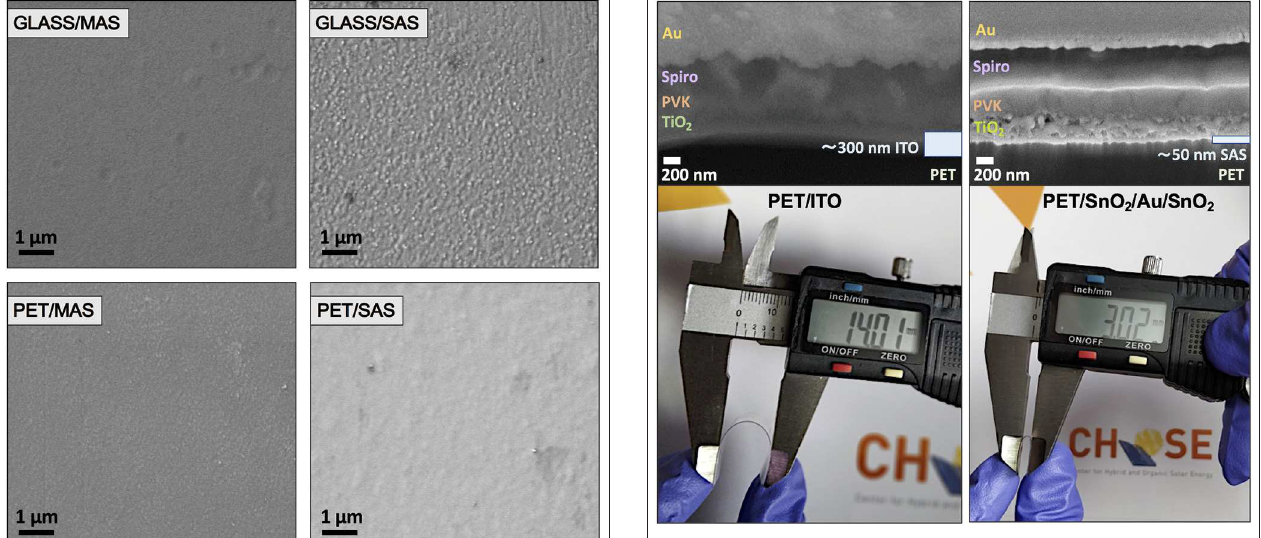
FIGURE 6 | Scanning electron microscopy (SEM) images of MoO x (18nm)/Au (10nm)/SnO 2 ( ∼ 15nm), labeled as MAS, and SnO 2 ( ∼ 25nm)/Au (10nm)/SnO 2 ( ∼ 15nm), labeled as SAS, electrodes on glass and PET substrates; the scale is 1 µ m.